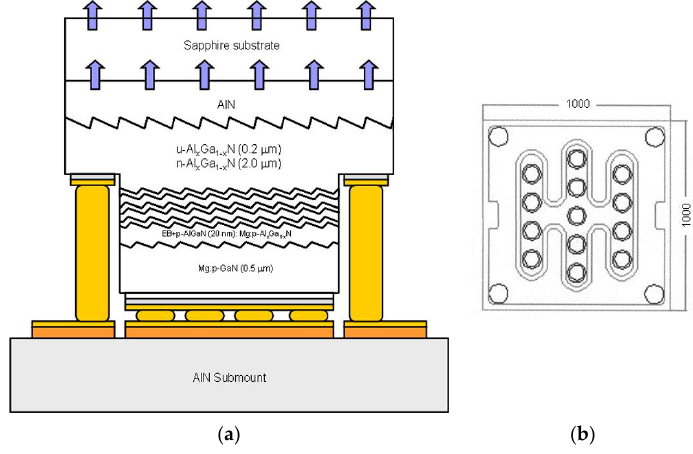
Figure 8. ( a ) Block diagram of DUV-LED die on thick sapphire with 1.0 ◦ miscut and submount. ( b ) Electrode pattern of interdigital n-contact on 1000 × 1000 µ m 2 die. The Au stud bumps used to flip-chip the die onto the submount are indicated by circles in the junction area. Thirteen and four bumps are located in the junction area and n-contact area, respectively. (( a , b ) are permitted to be reused from Jpn. J. Appl. Phys. [13]. © Japan Society Applied